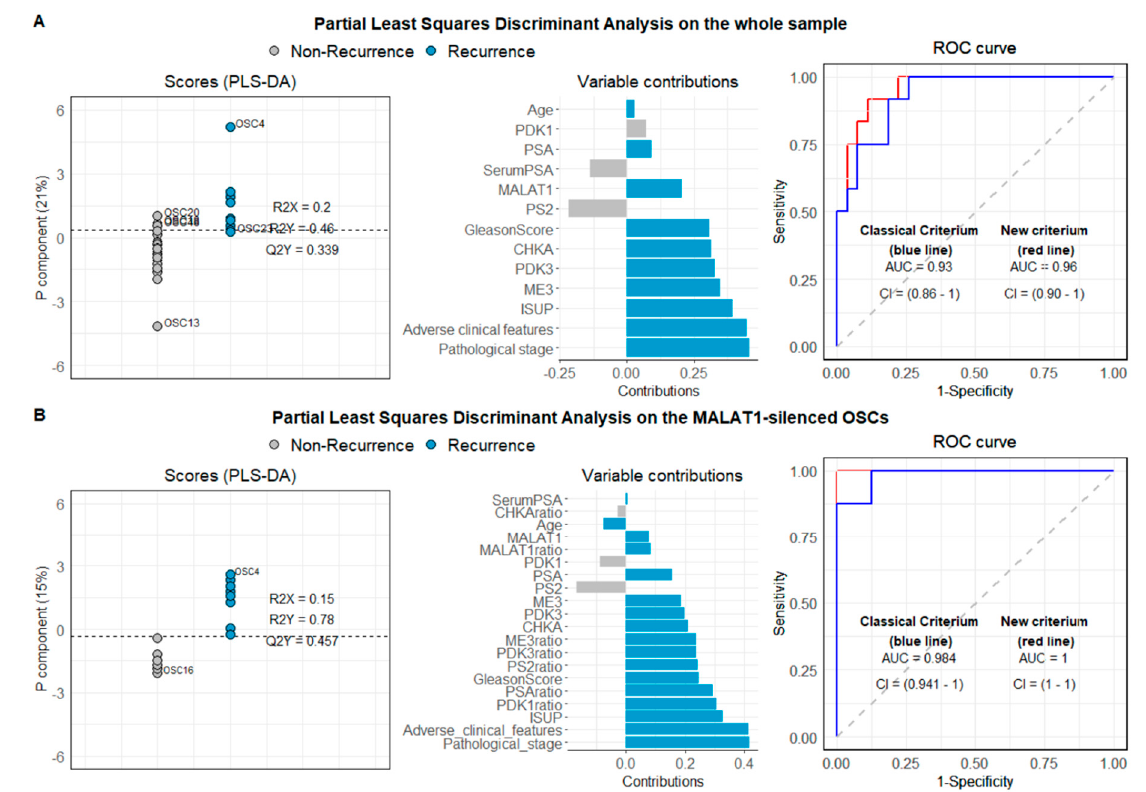
Figure 10. Partial least squares discriminant analysis (PLS-DA) on PCa-derived OSCs. PLS-DA was conducted on the whole sample ( A ) and MALAT1-silenced OSCs ( B ). The left panel reports the scores from the single component PLS-DA model. The separation threshold (dashed line) derives from the Youden criteria. The middle panel reports the variable loadings on the model component. Colors indicate the class (non-recurrent vs. recurrent patients) for which each variable assumes the maximal mean value. The right panel reports the ROC curves derived from the PLS-DA models for both the model, including the gene expression (new criterium) and the model including only the variables collected in the standard clinical practice (classical criterium).